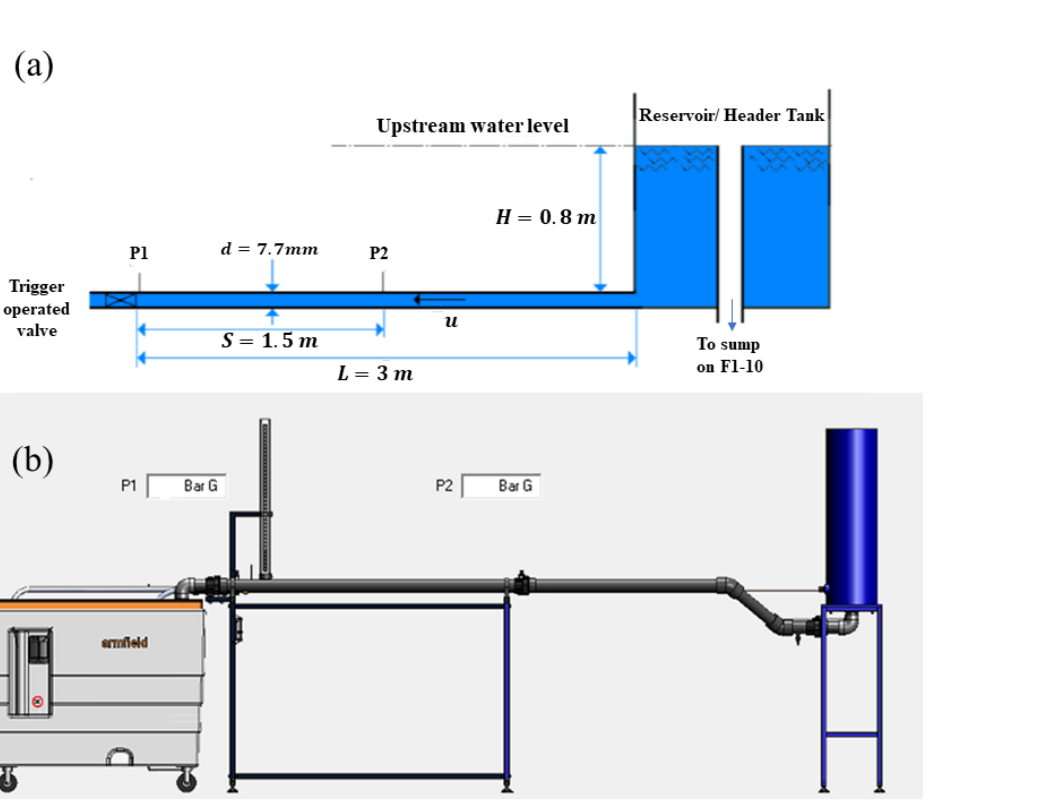
Figure 1. The diagram of a water hammer system, ( a ) schematic and ( b ) Armfield laboratory apparatus